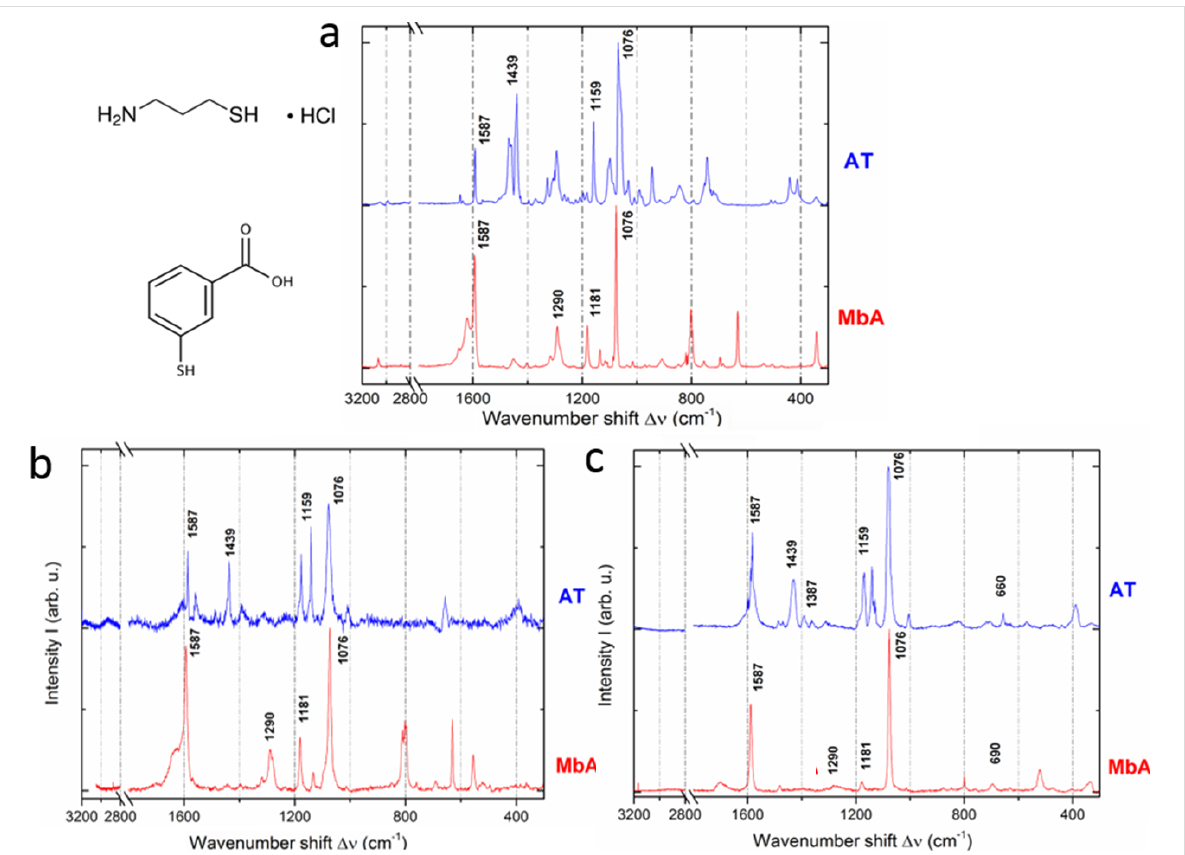
Figure 2: Raman spectra of thiols a) in powder form (with their molecular structures); b) in flat film form, after adsorption to the flat Au substrates from water solution; c) in film form on tAPA–Au.